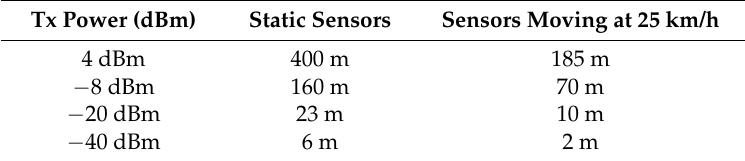
Table 1. Maximum coverage (m) for static and moving sensors, changing the transmission power.